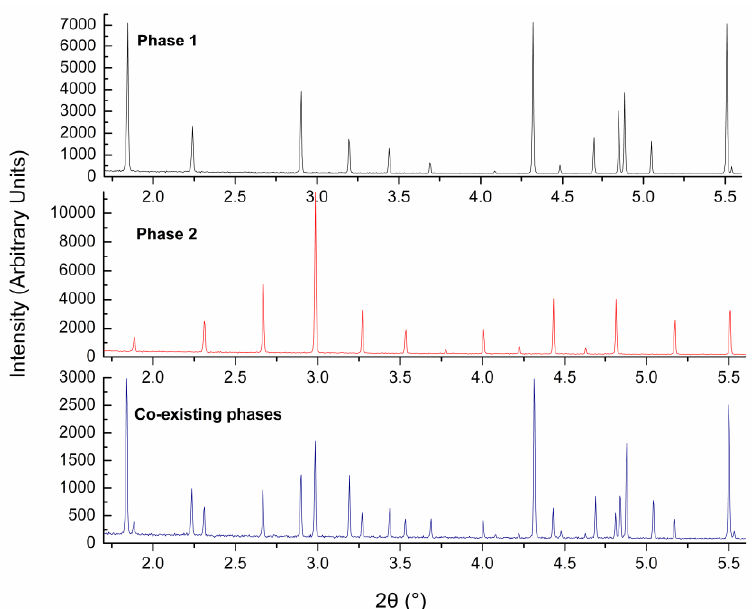
Figure 8. Overplot of three diffraction profiles. Upper and middle panels: The patterns correspond to human insulin samples of distinct (crystalline) polymorphs, evident from the differences in peak positions. Lower panel: Diffraction profile obtained from a sample where the two phases coexist, as it is manifested by the presence of peaks in both sets of positions, corresponding to each phase (Phase 1 and Phase 2).